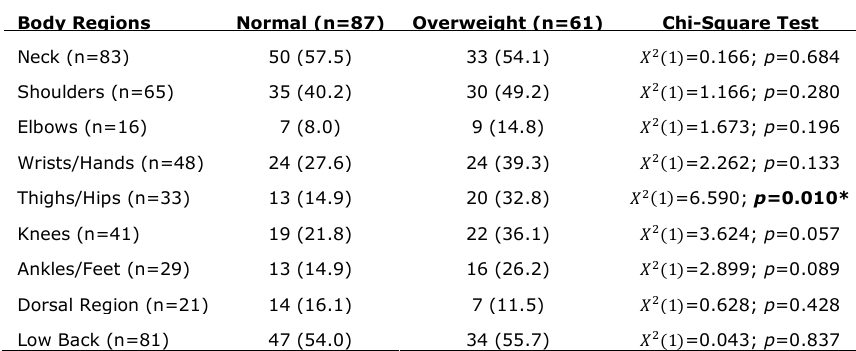
Table 3. Association between musculoskeletal symptoms and